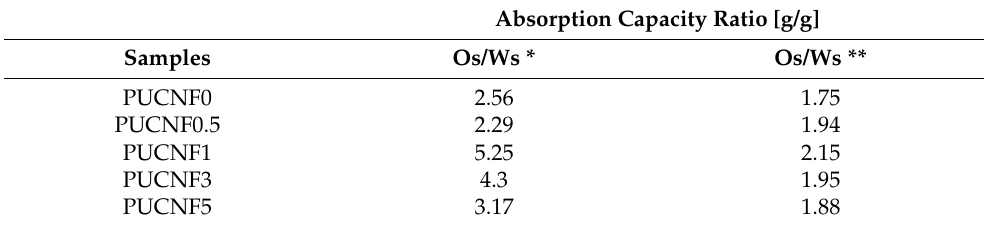
Table 2. Absorption capacity ratio in oil and water (Os, Ws) in pure (*) and mixed (**)